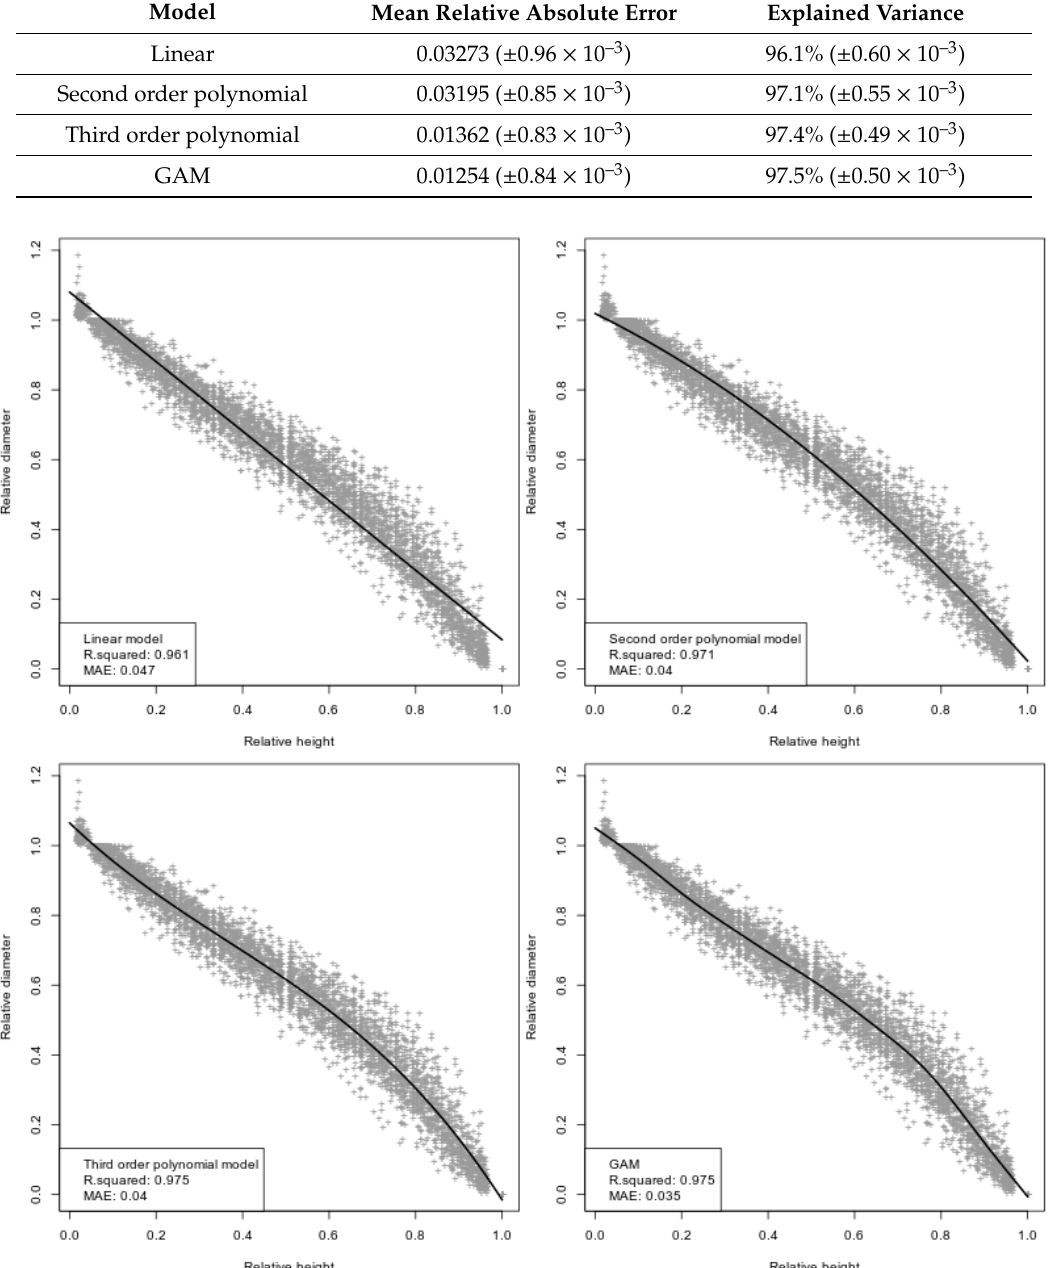
Table 2. Cross validation results.